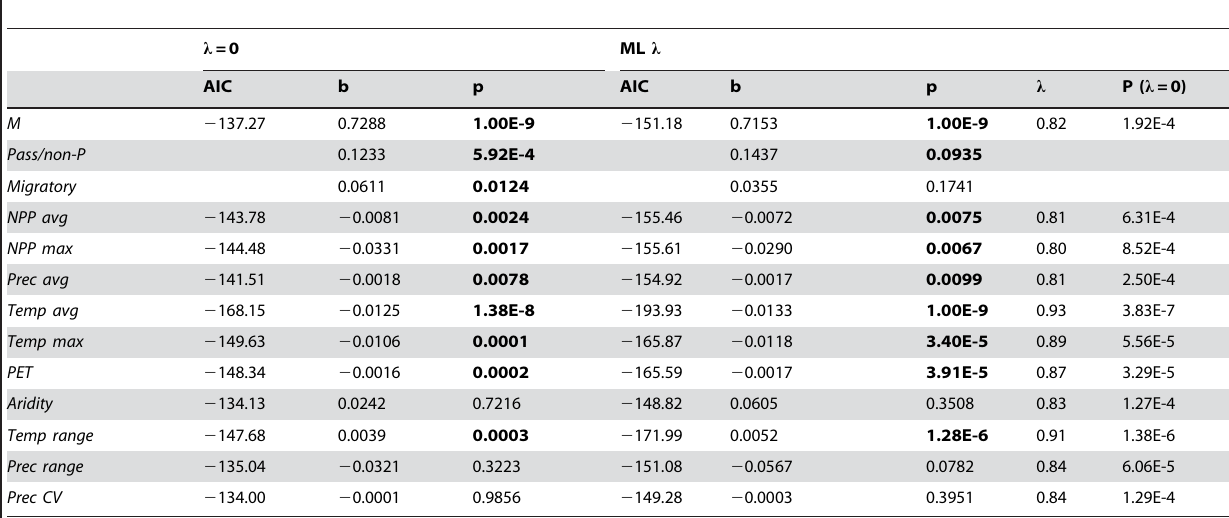
Table 2. Environment has strong effects on avian BMR, above and beyond migratory tendency.